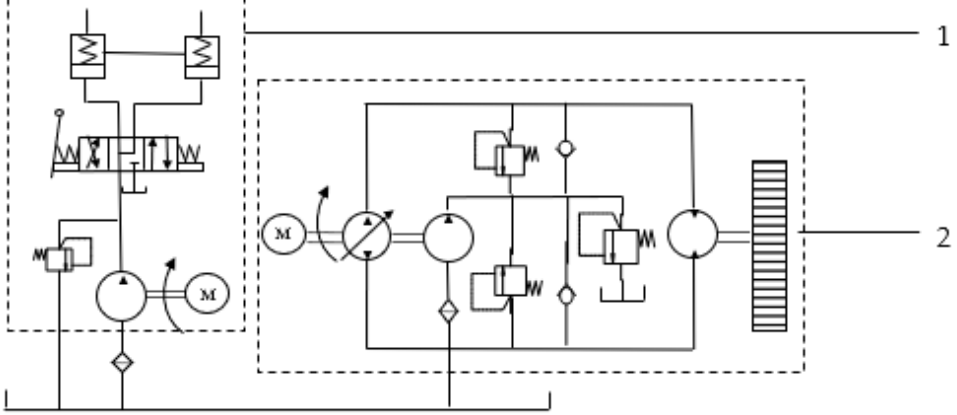
Figure 12. Principle of the hydraulic systems. 1. Hydraulic steering system; 2. Hydraulic speed regulating traveling system.